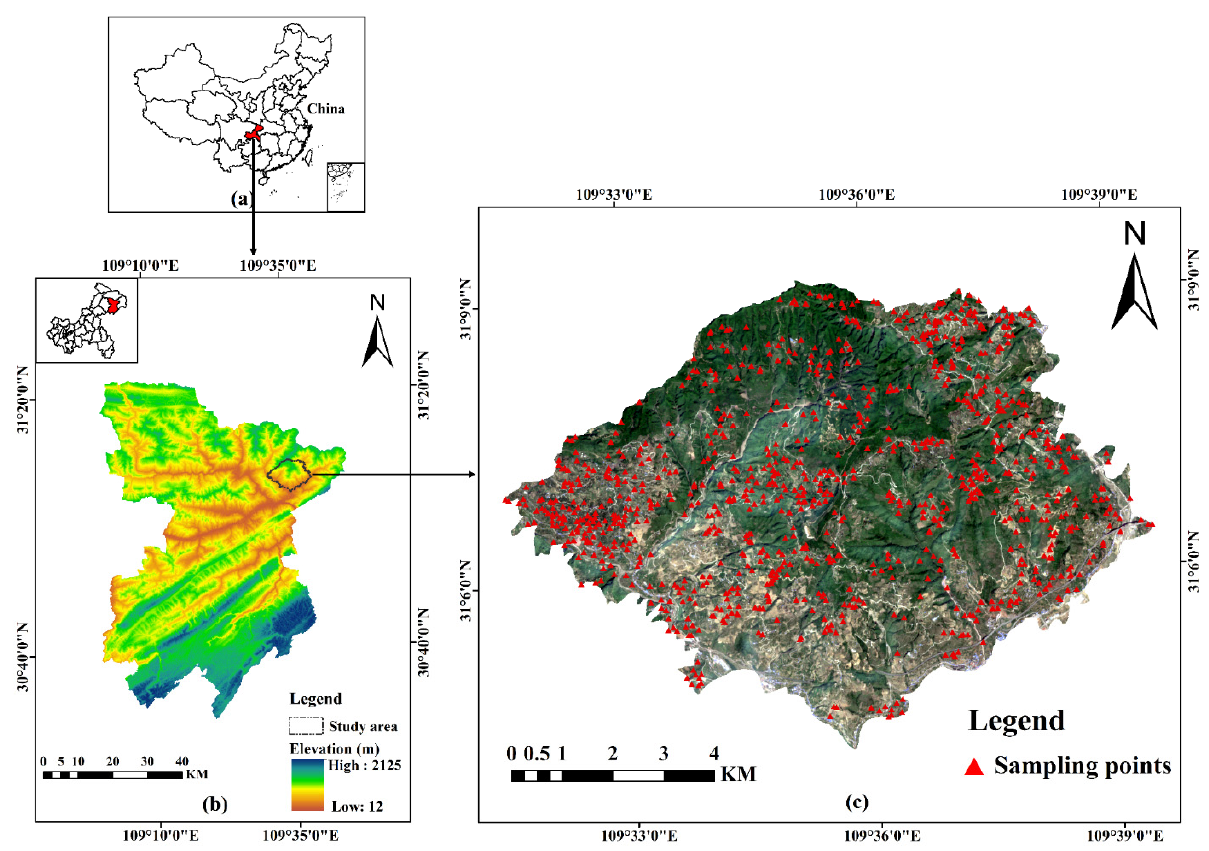
Figure 1. ( a ) Location, ( b ) digital elevation model (DEM), and ( c ) soil samples of the study area. Table 1. Number of samples for each soil texture class before and after the synthetic minority oversampling technique